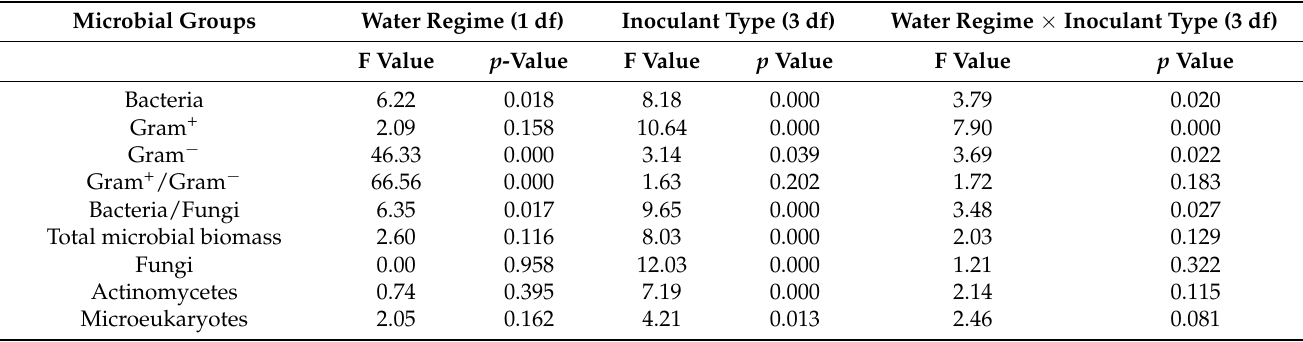
Table 4. Effects of water regime, inoculant type and their interaction on the biomass of individual microbial groups, and the bacteria/fungi and Gram + /Gram − ratios as revealed by two-way ANOVA (n = 4, df: degree of freedom). Microbial